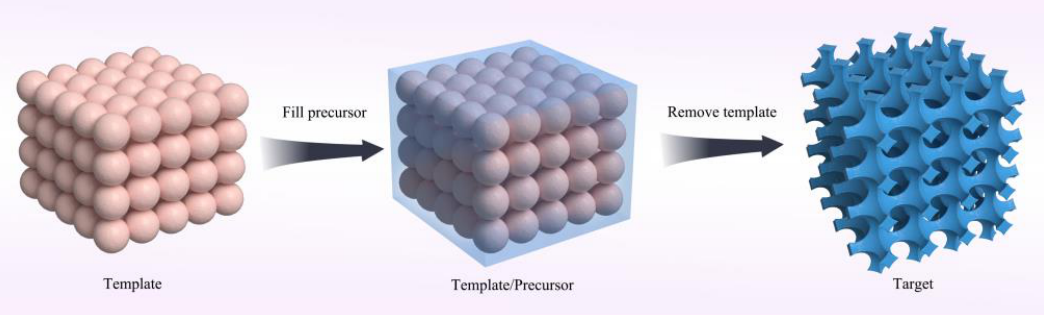
Figure 2. Conceptual diagram of the mechanism of the hard template method. Adapted with permission from Ref. [50]. 2006, WILEY-VCH Verlag GmbH & Co.